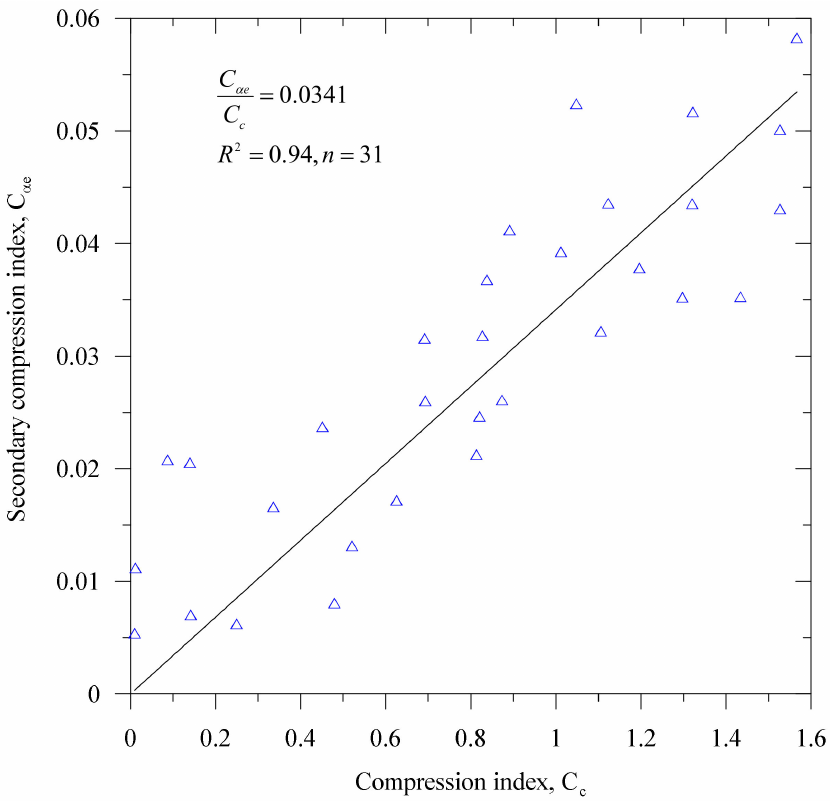
Figure 15. Relationship of the secondary compression index and compression index.